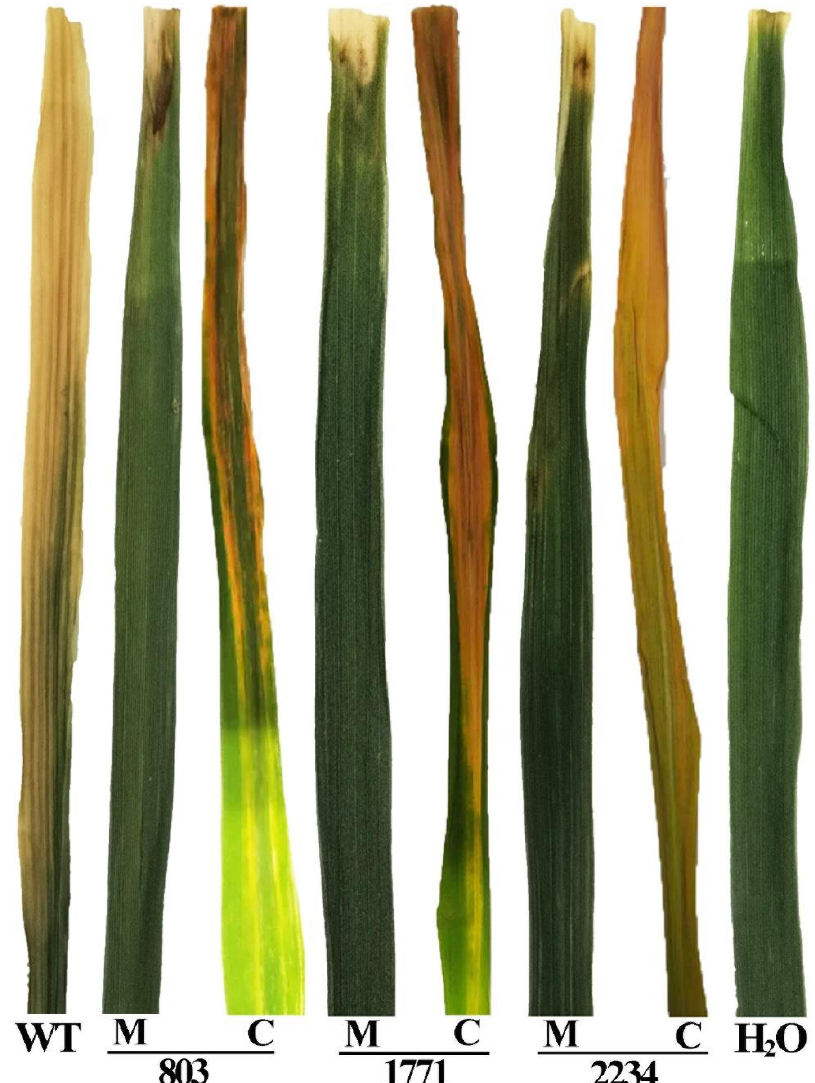
Figure 7. Influence of the 3 Tn5 mutants M488, M722, and M1070 in pathogenicity was demonstrated by leaf clipping inoculation of knockout mutants and complemented strains of the corresponding location genes on rice leaves. WT: Wild type; H 2 O: Negative control; M: Knockout mutant; C: Complemented strains.